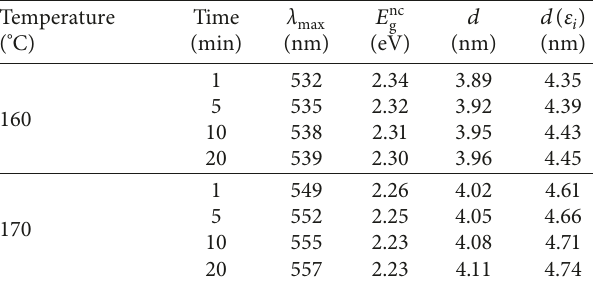
Figure 8: Temperature variation of core band gap energy (a) and diameter (b) of bare CdSe core QDs processed at 1, 5, 10, and 20 minutes of reaction times, respectively. Table 3: UV-Vis maximum wavelength and corresponding measured band gap and calculated unstrained and strained core diameter of CdSe/ZnS QDs synthesized at 160 ° C and 170 ° C for different reaction times